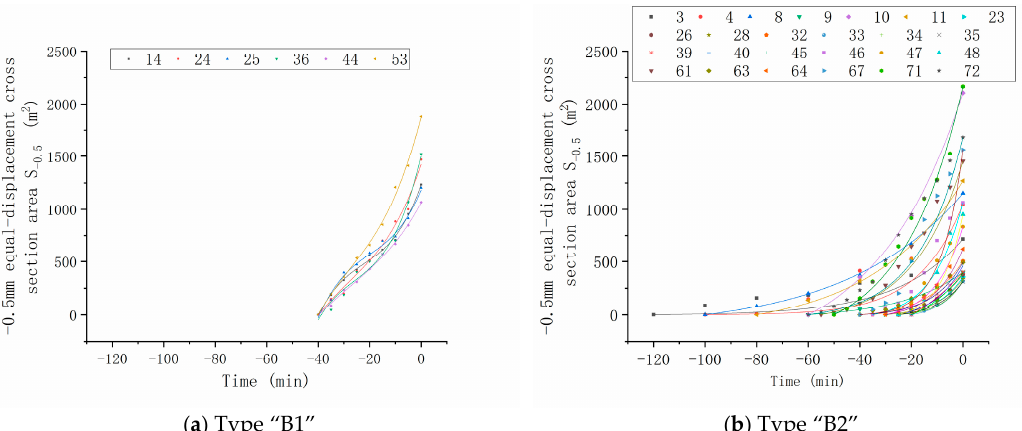
Figure 9. The area–time curve of the equal displacement cross section. The numbers in the legend represent landslide numbers recorded in chronological order. The “0” time represents the last scan before the severe landslides.